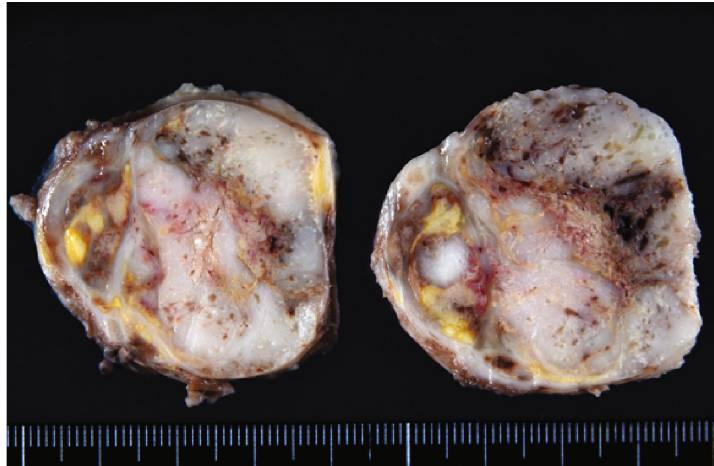
Figure 2: Macroscopic fi ndings for the retroperitoneal mass. The cut surface showed a relatively circumscribed tumor. Hemorrhage and necrosis were